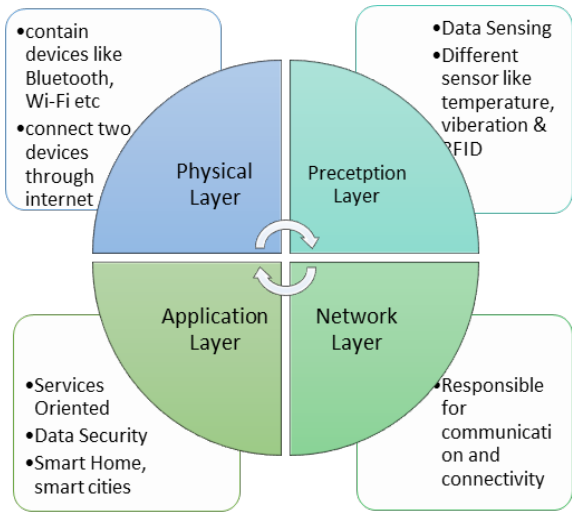
Figure 2 . Four-Layer Architecture for IoT